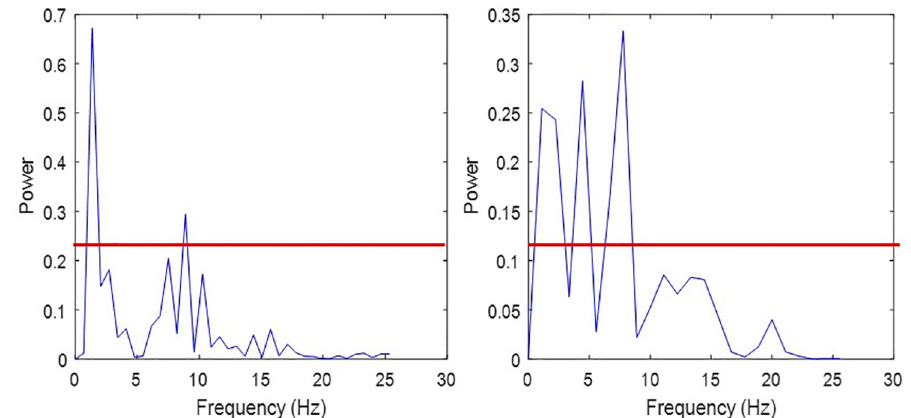
Fig 5. Peak distinction for two different steps. Peak distinction for two steps. (a) A step with a very distinct peak, having a peak distinction of 5.26%. (b) A step with a less distinct peak, having a peak distinction of 20.83%. Horizontal red lines indicate one third of max